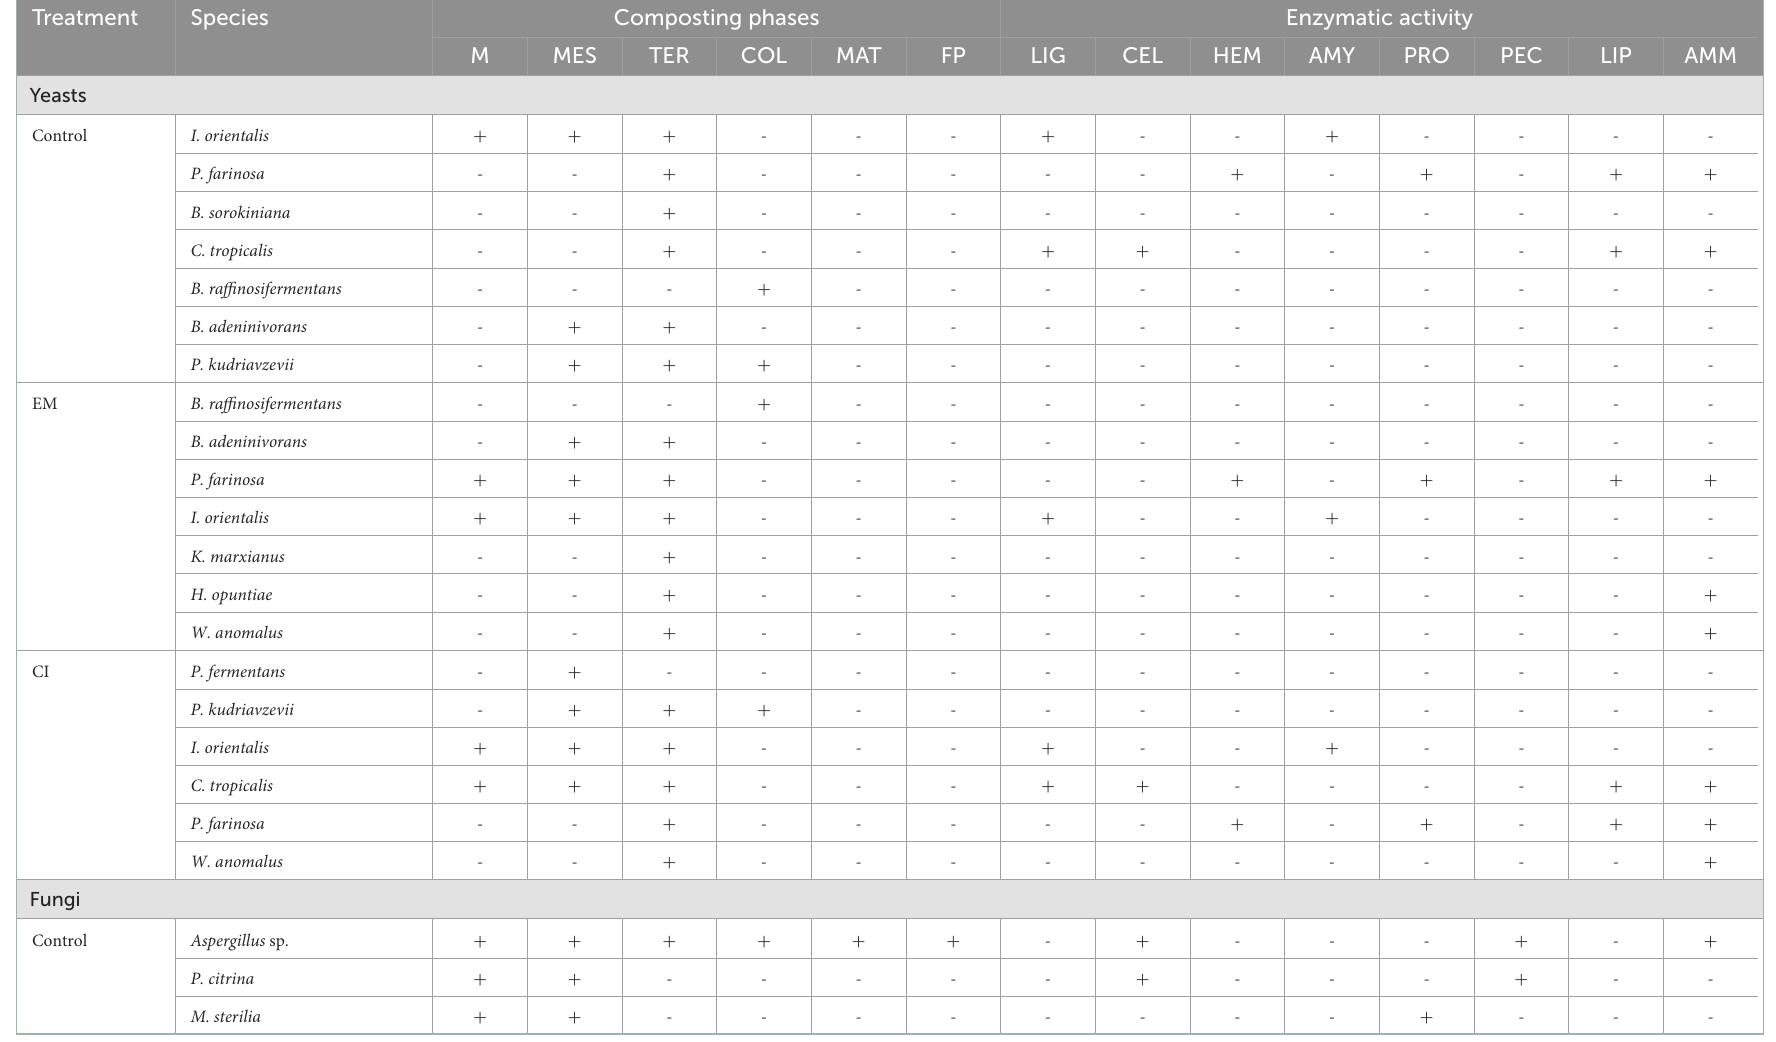
TABLE 5 Persistent microorganisms isolated during different phases of the composting